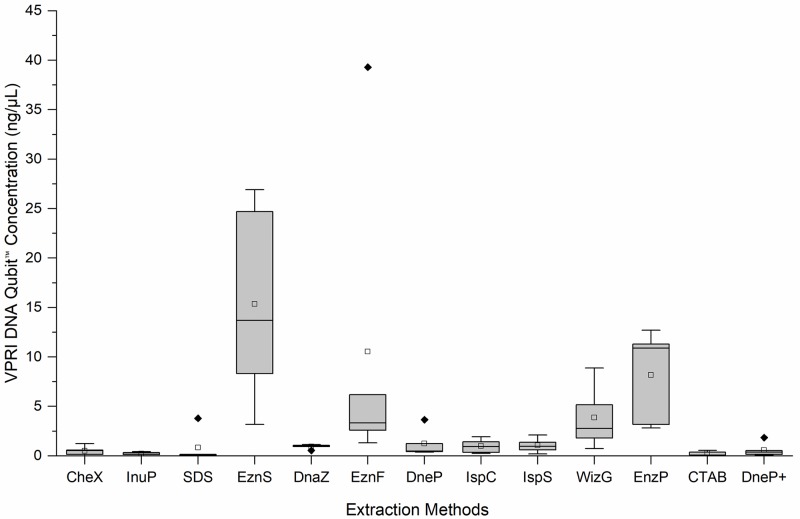
Boxplots of the DNA concentrations (ng/μL) of five victorian plant pathology herbarium (VPRI) apple powdery mildew specimens produced by 13 extraction protocols as measured by Invitrogen Qubit™ fluorometer.Median line __; Mean □; Outlier ◆ Extraction method abbreviations: Chelex®100 (CheX), innuPrep Plant DNA (InuP), sodium dodecyl sulphate (SDS), E.Z.N.A.® SP Plant (EznS), DNAzol™ (DnaZ), E.Z.N.A.® Forensic DNA (EznF), Qiagen DNeasy® Plant (DneP), Isolate II Plant DNA Lysis buffer PA1 C (IspC), Isolate II Plant DNA Lysis buffer PA2 S (IspS), Wizard® Genomic DNA Purification (WizG), E.Z.N.A.® Plant (EznP), Cetyl trimethyl ammonium bromide (CTAB) and Qiagen DNeasy® Plant plus PTB (DneP+).